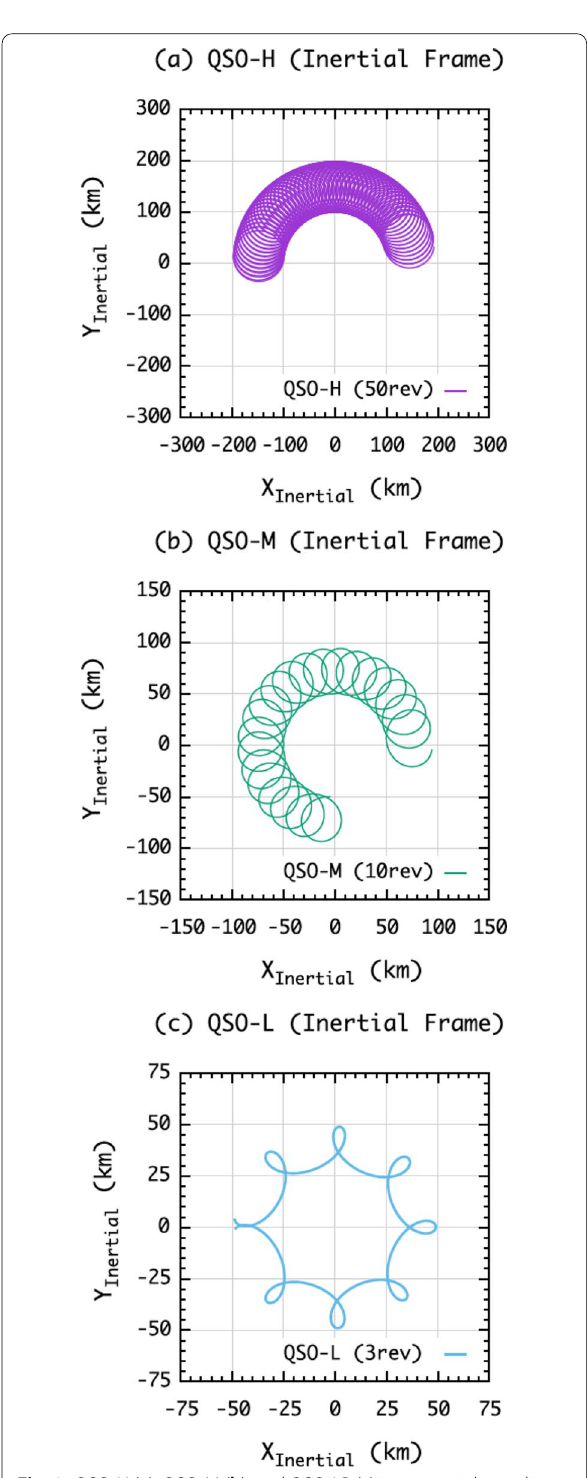
Fig. 3 QSO‑H ( a ), QSO‑M ( b ), and QSO‑LB ( c ) in an inertial coordinate system centered on Phobos. The left side of Phobos corresponds to the day side. In these figures, Phobos rotates at the